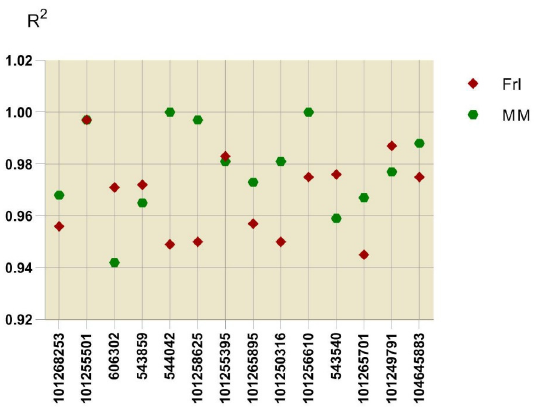
Figure 7. Coefficients of association between RNA sequencing and qRT-PCR results. The expression patterns of each gene in both Frl (0, 3, and 6 dpi) and MM (0, 3, and 6 dpi) were analysed. The outcomes acquired from these approaches were utilised to compute the coefficients of association (R 2 values). All points denote R 2 values. MM, ‘Moneymaker’; Frl ,